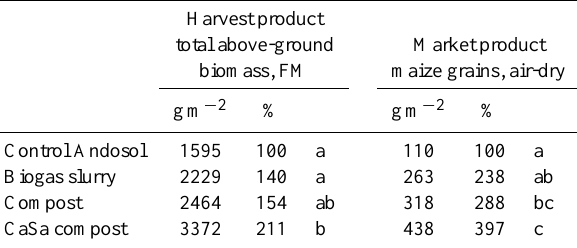
Table 5. Harvest and market products of maize and in relation to the untreated control